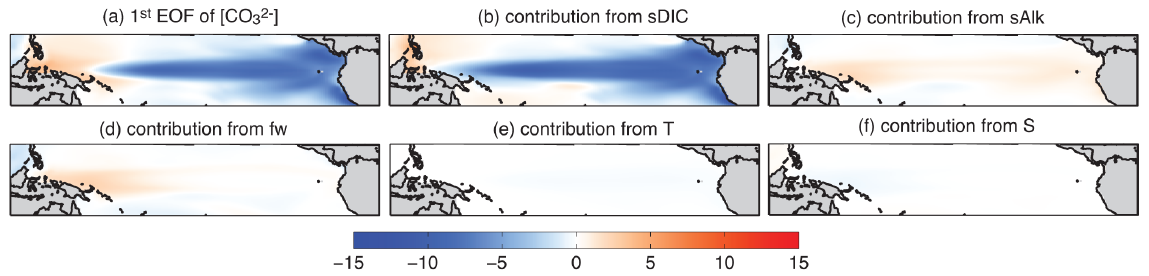
Figure 7. (a) Leading EOF of tropical Pacific surface ocean [CO 2 − temperature, and (f) salinity as in Eq. (4) (mmolm − 3 ).